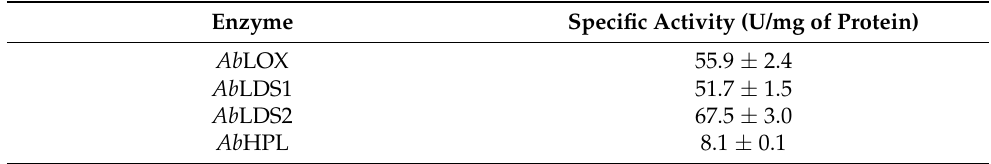
Table 1. Activities of the prokaryotic-expressed enzymes related to the synthesis of 1-octen-3-ol by Agaricus bisporus .